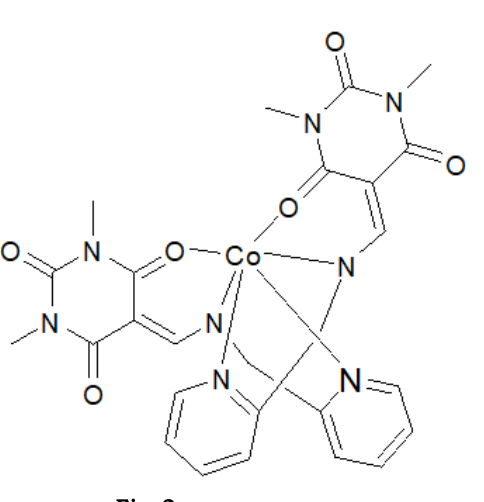
Fig. 2 . Structure of [CoL 2 ] NO